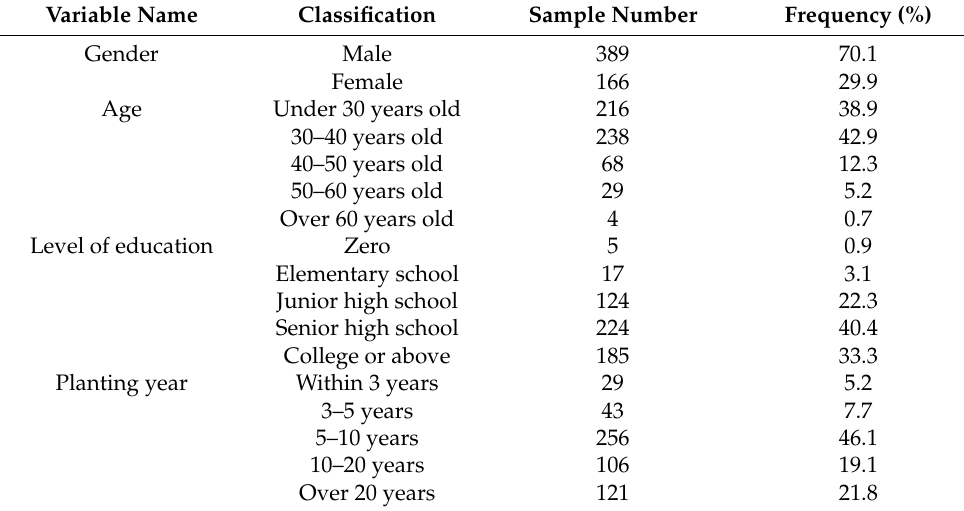
Table 2. Sample basic information statistics.